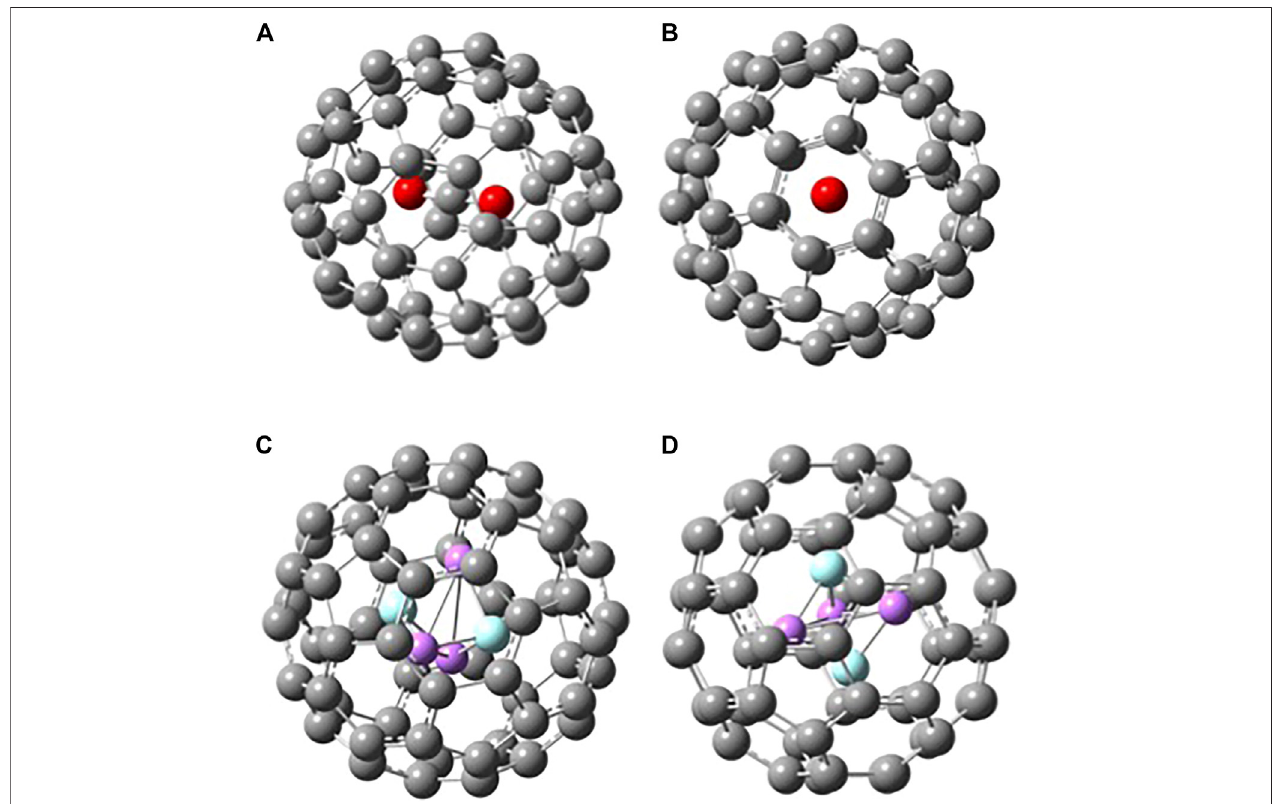
FIGURE 3 | Two different views of B3LYP/6-31G* optimized structures of (A) - (B) C 60 · CO 2 and (C) - (D) C 60 · Li 3 F 2 (D 3h ).